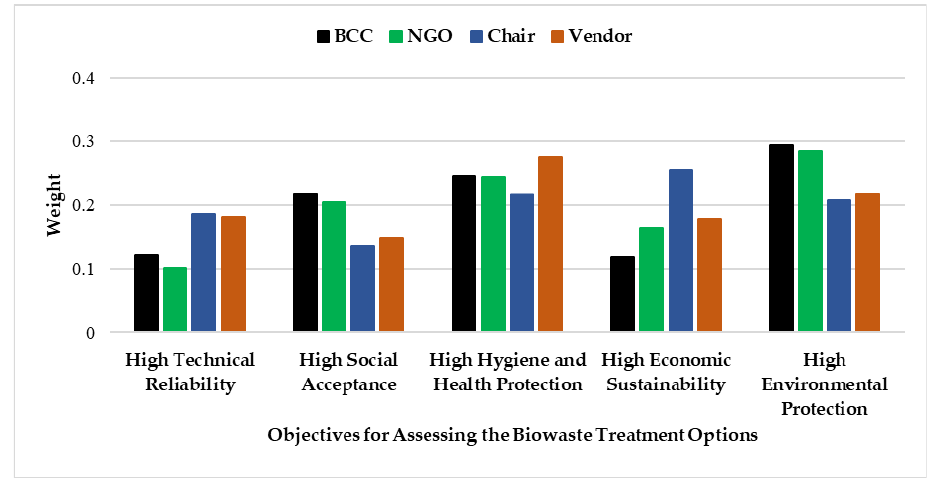
Figure 3. Weights based on stakeholder preferences for the objectives.